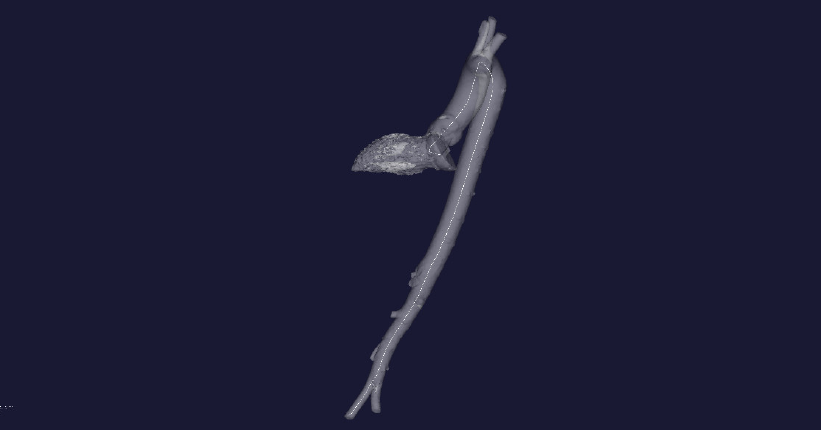
Figure 4. STL-reconstruction of the aortic flow channel for a patient without severe pathology and the central line inside the channel.